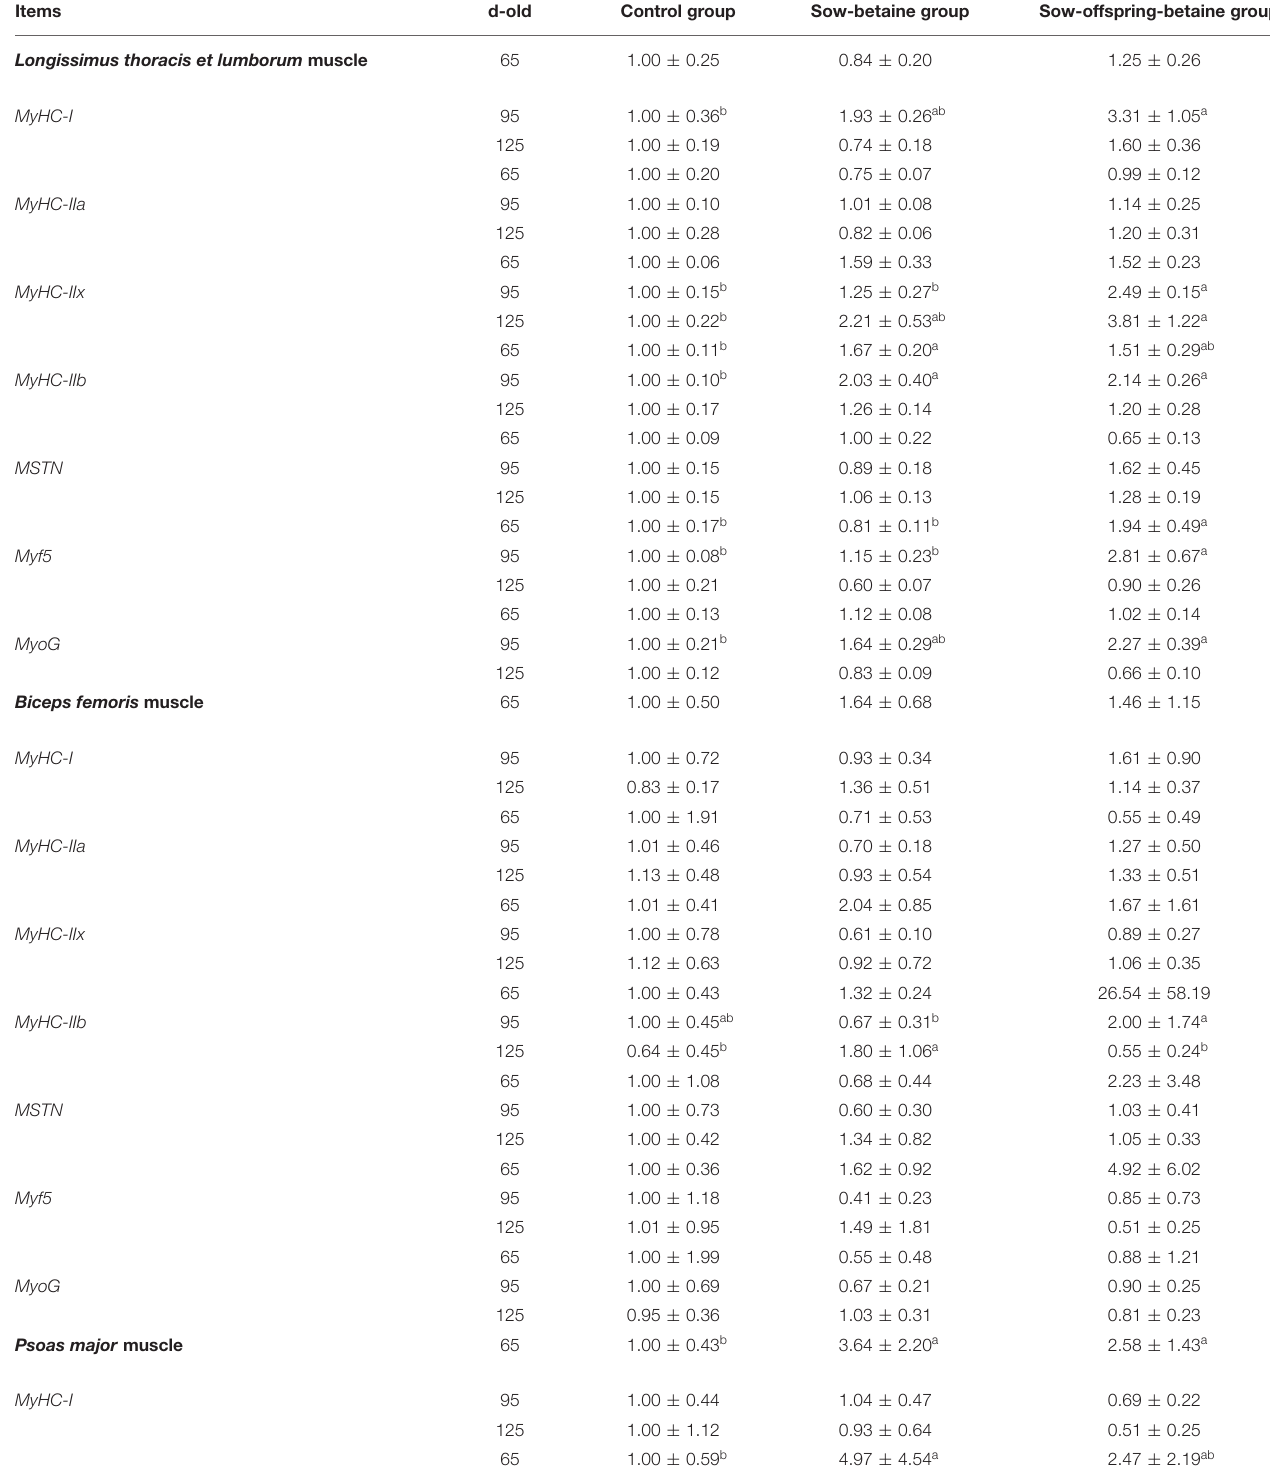
TABLE 7 | Effect of dietary betaine on the expression of genes related to MyHC isoform and MRFs in the muscle of Bama mini-pigs. Items d-old Control group Sow-betaine